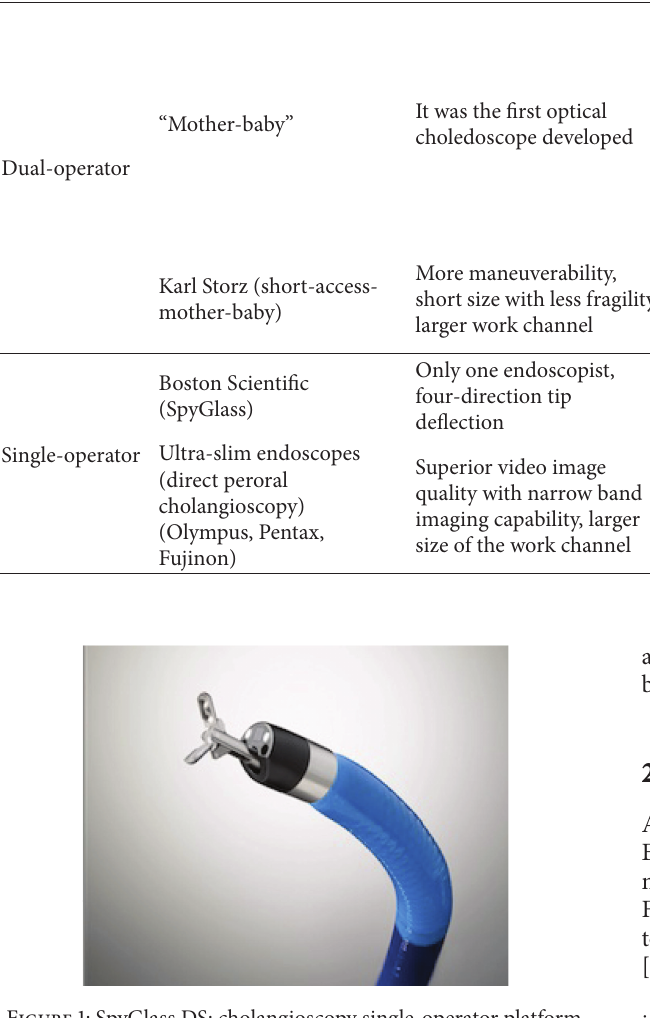
visualization of the biliary tree and led to more widespread use of cholangioscopy [4, 10–15]. Cholangioscopy modalities are summarized in Table